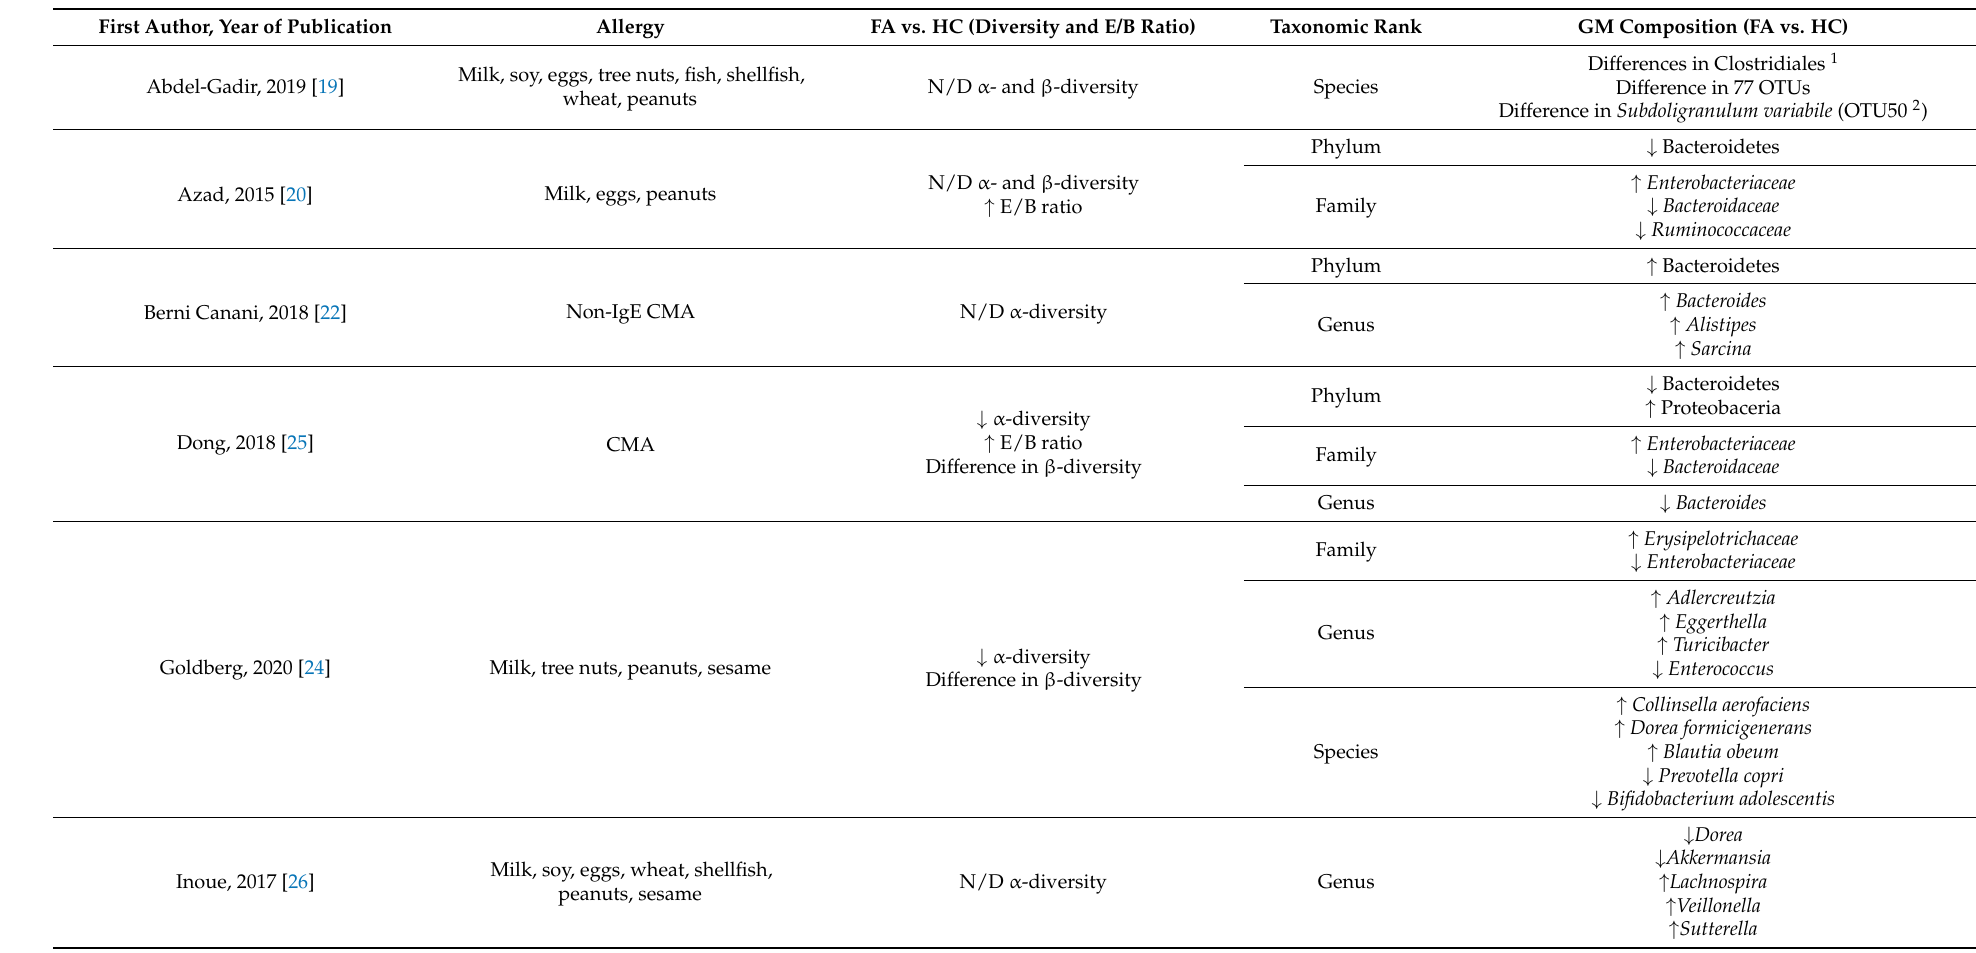
Table 4. Results from studies exploring gut microbiota in children with food allergies compared to healthy